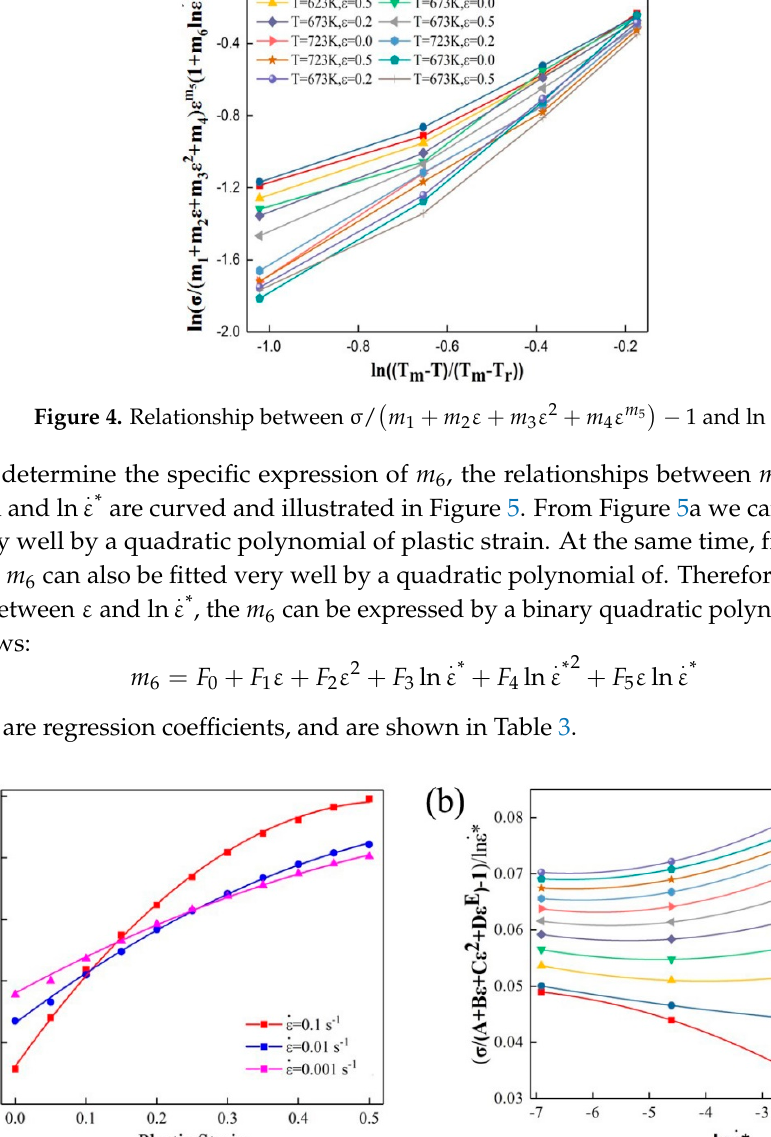
Figure 5. The relationship between m 6 and plastic strain ( a ) and ln ε * ( b ). Table 3. The regression coefficients of the fuction m 6 =